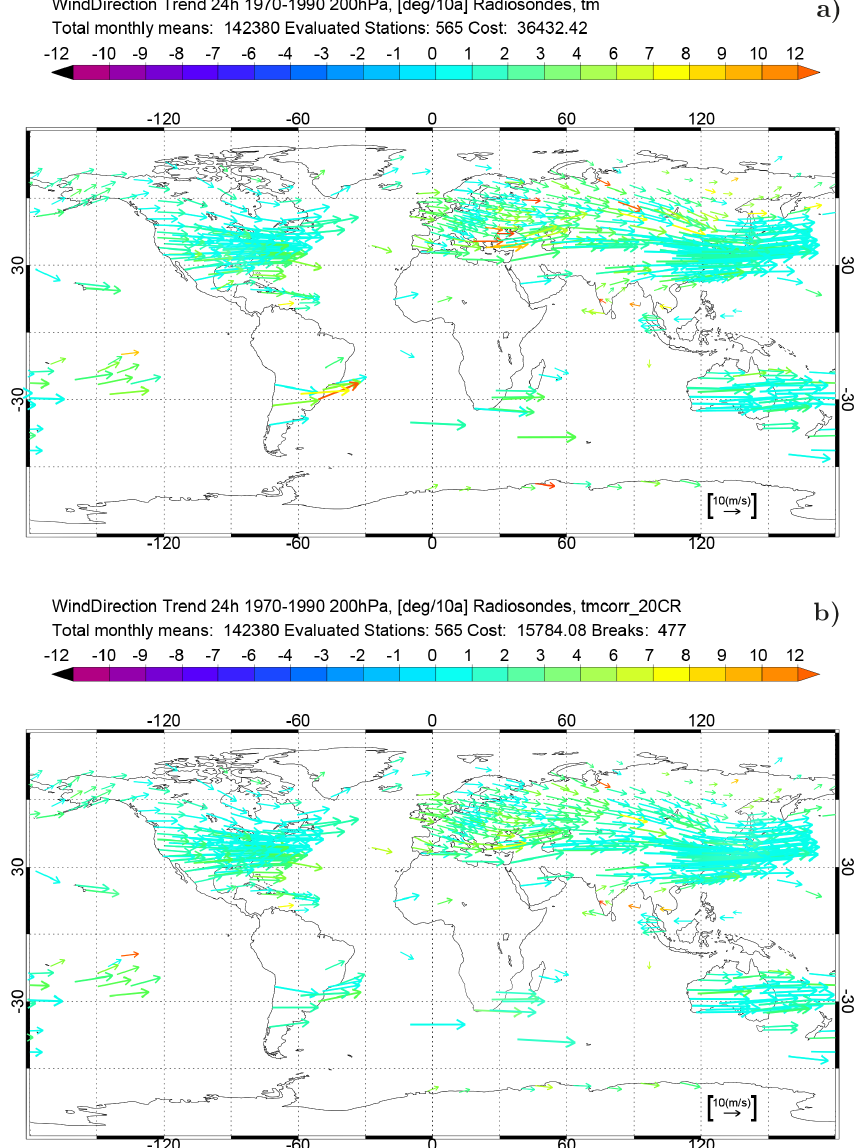
Figure 14. Global observed wind direction trends at 200hPa for the period 1970–1990, (a) before adjustment, (b) after adjustment with RAOBCORE. 565 WMO stations with less than three missing years in the inquired period have been used. The length, direction and color of the arrows have the same meaning as in Fig.